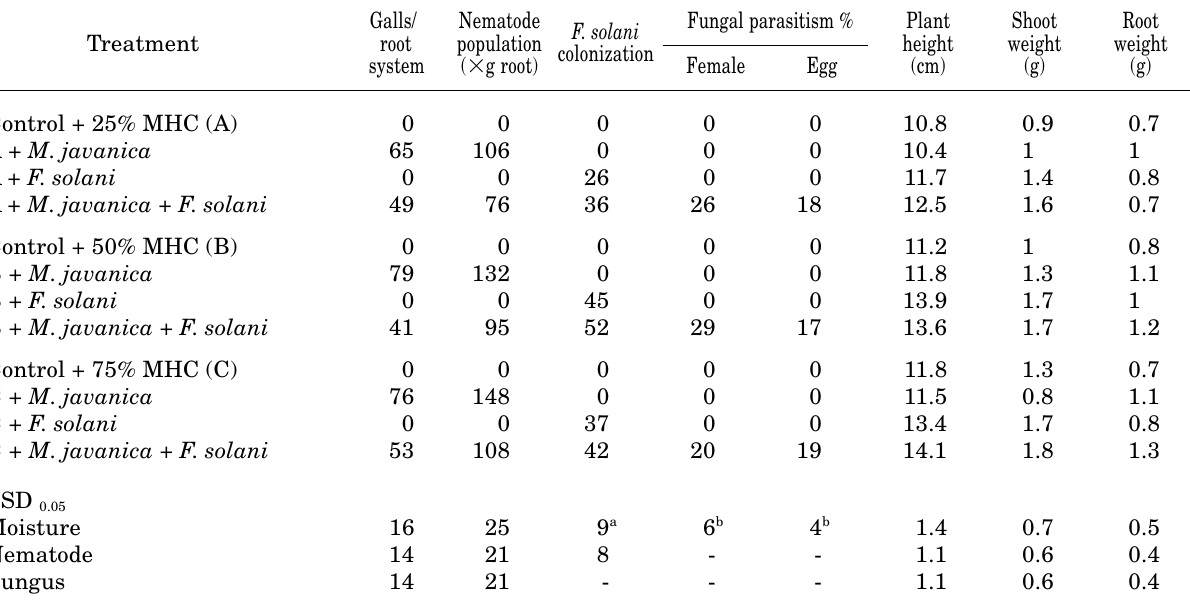
Table 3. Effect of Fusarium solani strain Fs5 at various soil-moisture levels on Meloidogyne javanica on tomato, as shown by the development of root-knot infection, M. javanica invasion, root colonization by F. solani , female and egg parasitism by the fungus, and growth of tomato plants.